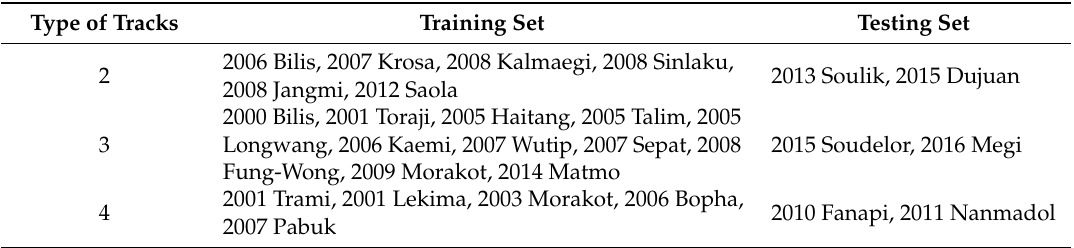
Table 2. Classification of typhoon